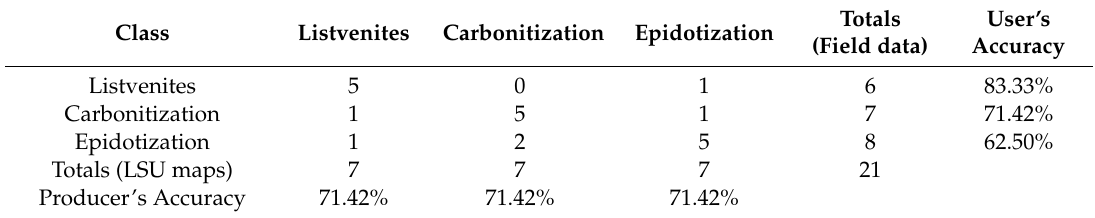
Table A4. Confusion matrix for LSU classification mineral maps versus field